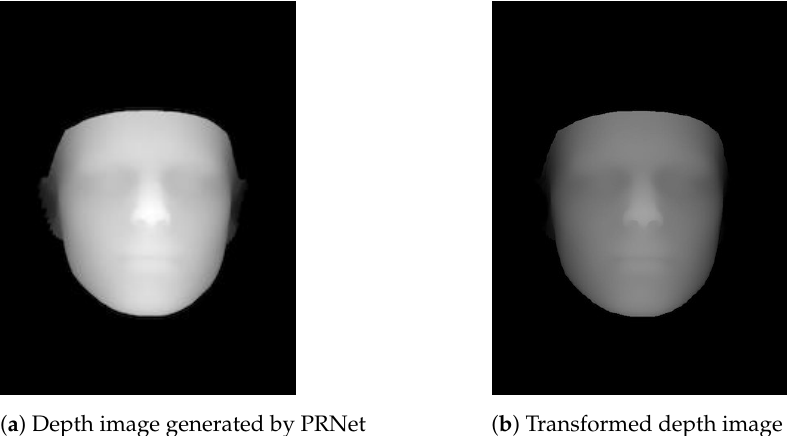
Figure 6. Example of ( a ) a depth map generated from a facial image using PRNet and ( b ) after it has been transformed. Note, that the original depth map ( a ) corresponds to the input image in Figure 2.